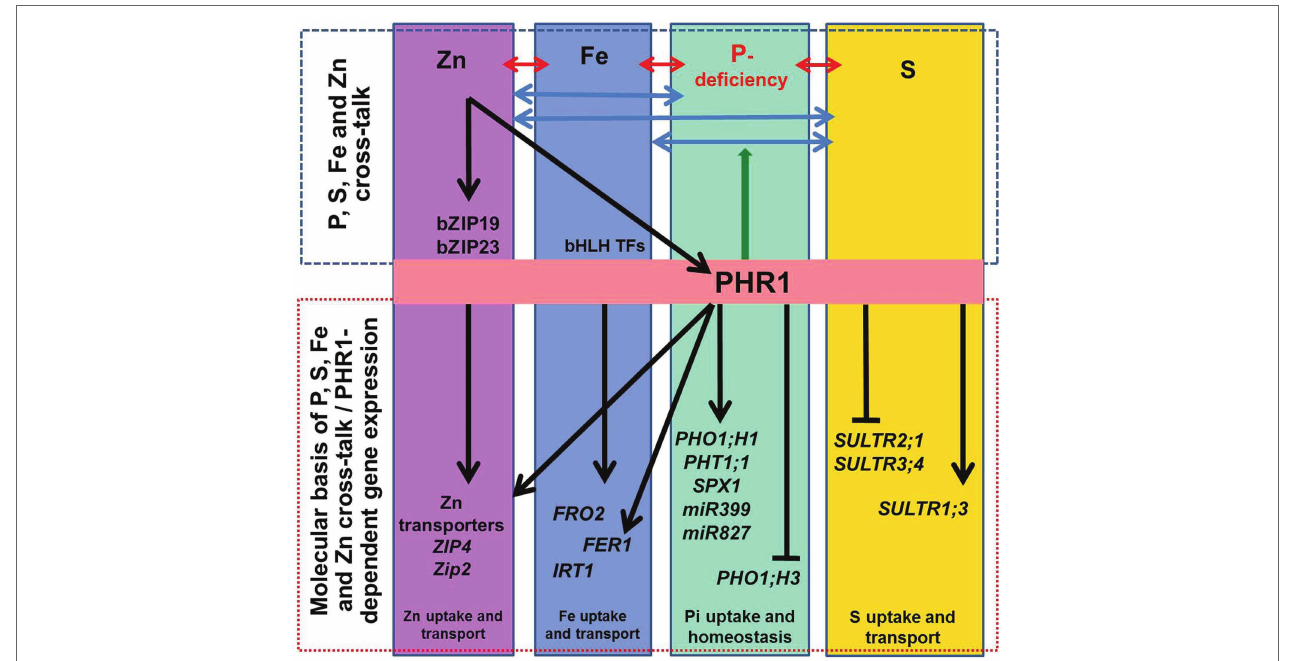
FIGURE 2 | Schematic representation of the macro‐ and micro-nutrient homeostasis. The interactions between phosphorus (P), iron (Fe), sulfur (S), and zinc (Zn) homeostasis are indicated by ↔ arrows. At the molecular level, transcription factor PHR1 (initially identified as a key regulator of the phosphate-starvation induced genes) up-regulates phosphate transporters ( PHT1;1 ), PHO1;H1 , and the genes involved in phosphate deficiency sensing/signaling ( SPX1 , miR399 , and miR827 ). Other genes known to be involved in P-deficiency signaling/sensing include miR827 and miR399 . Transcriptional regulation of some of the genes involved in maintaining Fe and Zn homeostasis is PHR1-dependent; it includes FER1 (encoding Fe storage protein ferritin) and ZIP2 and ZIP4 (zinc transporters). PHR1 also acts as a central regulator of sulfate transport ( SULTR1;3 , SULTR2;1 , and SULTR3;4 ). The arrow-heads and flat-ended lines indicate the positive and negative effects of PHR1, respectively. PHR1 acts as a regulator of P-transporters (PHT1 and PHO1) via the PHR1–miR399–PHO2 module. Also, ZIP2 and ZIP4 are activated by PHR1 binding to the P1BS sequences in the promoter of the genes. Likewise, Zn sufficiency inactivates the Zn-regulatory network and represses Zn transporters for Zn homeostasis. Besides, PHO1;H3 is repressed by sufficient Zn supply, and the PHR1 and PHO1 proteins help to maintain the Pi–Zn homeostasis cross-talk. Similarly, Fe homeostasis is also regulated in a PHR1-dependent